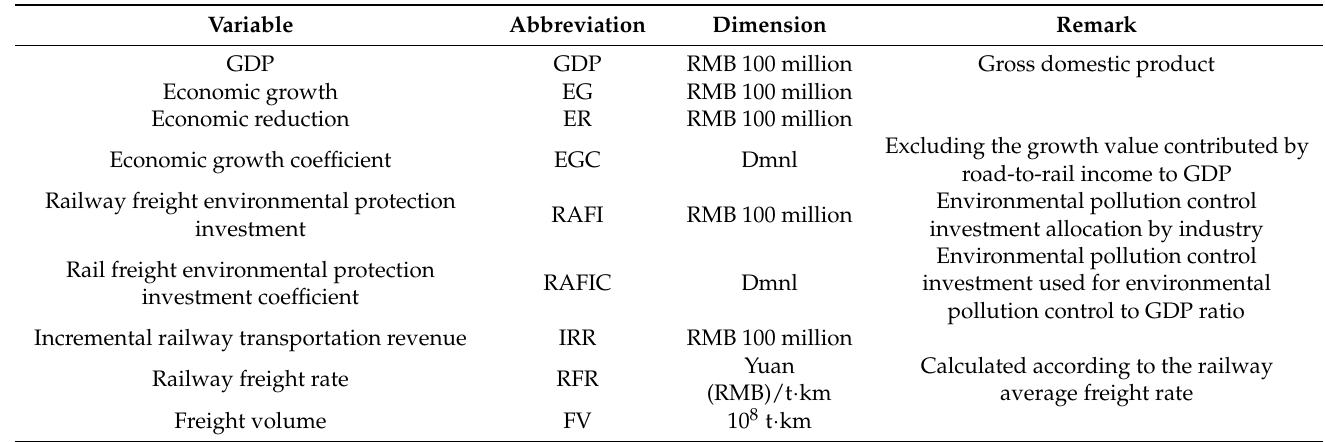
Table 2. Variable